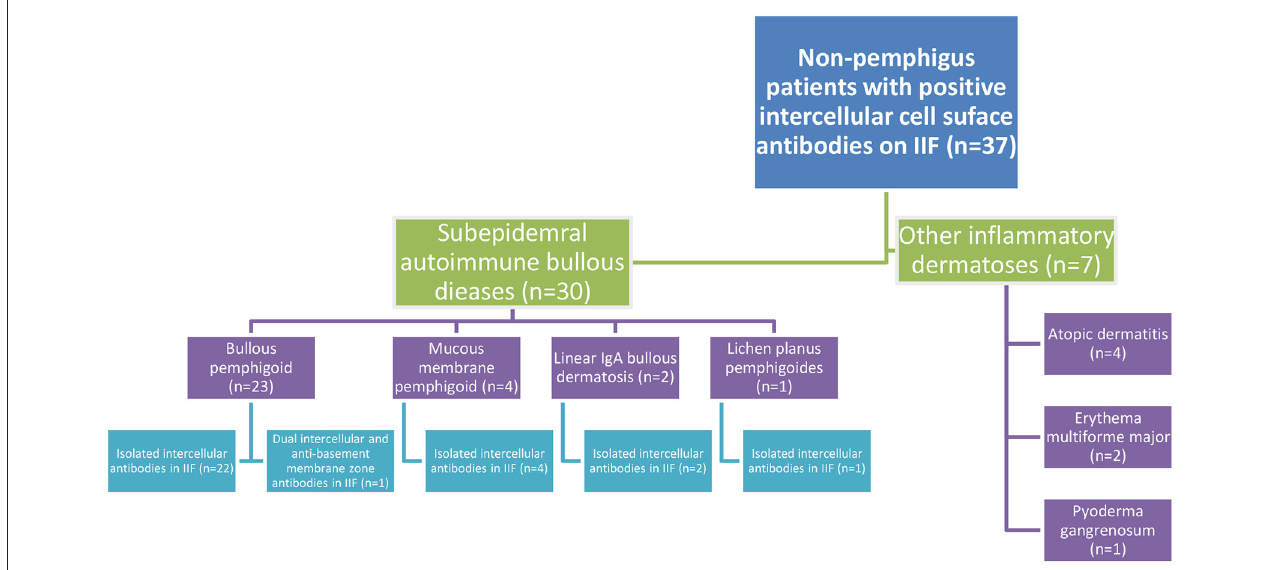
FIGURE 1 | Flowchart of the clinical characteristics of non-pemphigus patients tested positive for intercellular cell surface antibodies in IIF on monkey